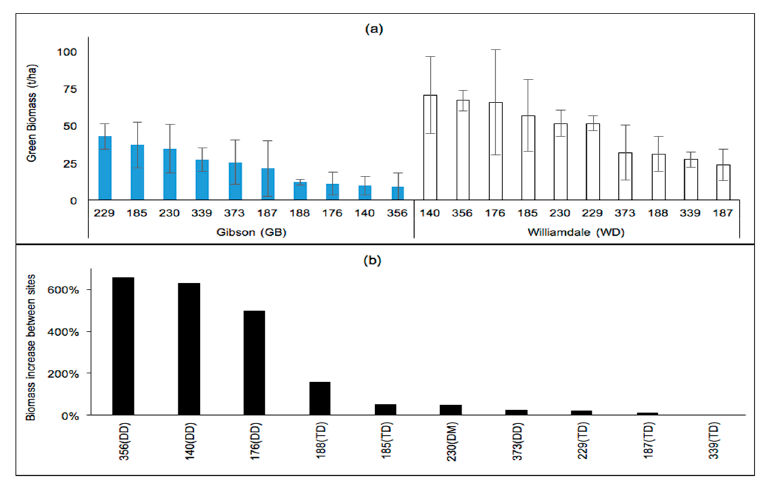
Figure 6. ( a ) Four-year-old green wood biomass (t/ha) of poplars located in the Coastal Plains under irrigated (GB) and non-irrigated (WD) conditions; ( b ) clonal biomass increases (%) at WD relative to those at GB.